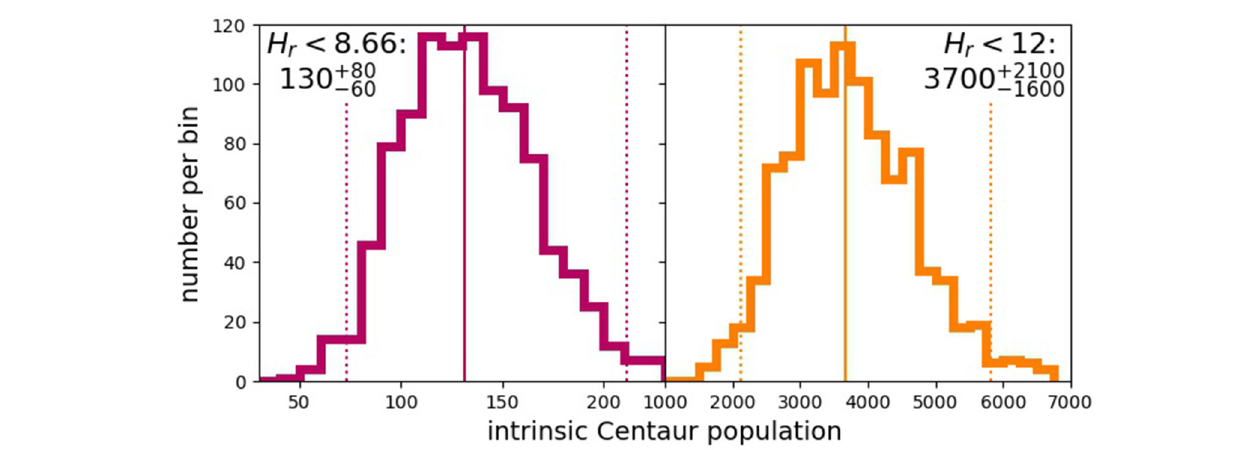
FIGURE 3 | The range of intrinsic Centaur population sizes required for the Survey Simulator to produce the same number of Centaur detections (17) as were discovered by the OSSOS ensemble, H r < 8.66 intrinsic populations shown in red (Left) and H r < 12 shown in orange (Right) . The solid lines highlight the median population, and dotted lines show the 95% upper and lower confidence limits on the intrinsic Centaur population for each H -magnitude limit. Using the OSSOS ensemble, we measure an intrinsic populations of 130 + 80 − 60 H r < 8.66 Centaurs and 3700 + 2100 − 1600 H r < 12 Centaurs with 95% confidence.